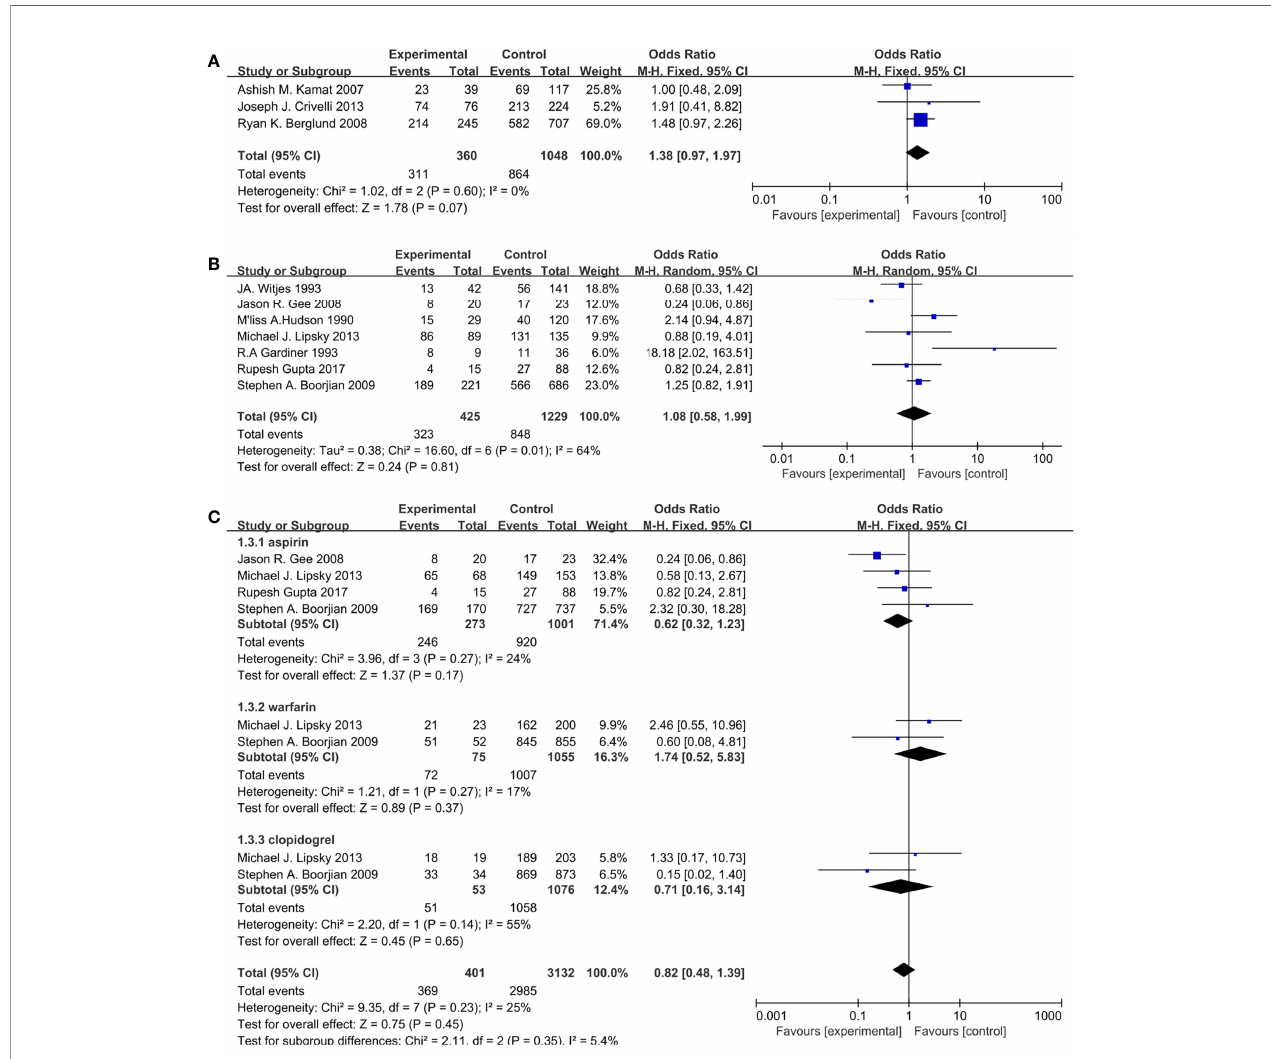
FIGURE 2 | Forest plot for cardiovascular drugs ’ effect on recurrence: (A) Statins, (B) fi brin clot inhibitors, (C) subgroup analysis of fi brin clot inhibitors (aspirin, warfarin, and